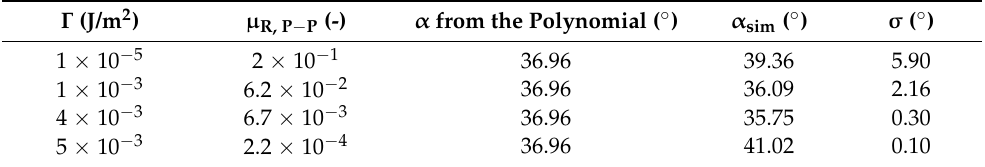
Figure 8. Schematic of the static angle of repose calibration methodology in a flow chart. Γ and Γ P − G are the interfacial adhesive surface energy between the particles and between the particles and the geometry, respectively. Table 3. Comparison between the predicted α ( α from the polynomial) and the one obtained from the simulations ( α sim ) for the reported pairs of the parameters ( Γ and µ R,P − P ) to verify the reliability of the prediction. σ is the standard deviation of α sim